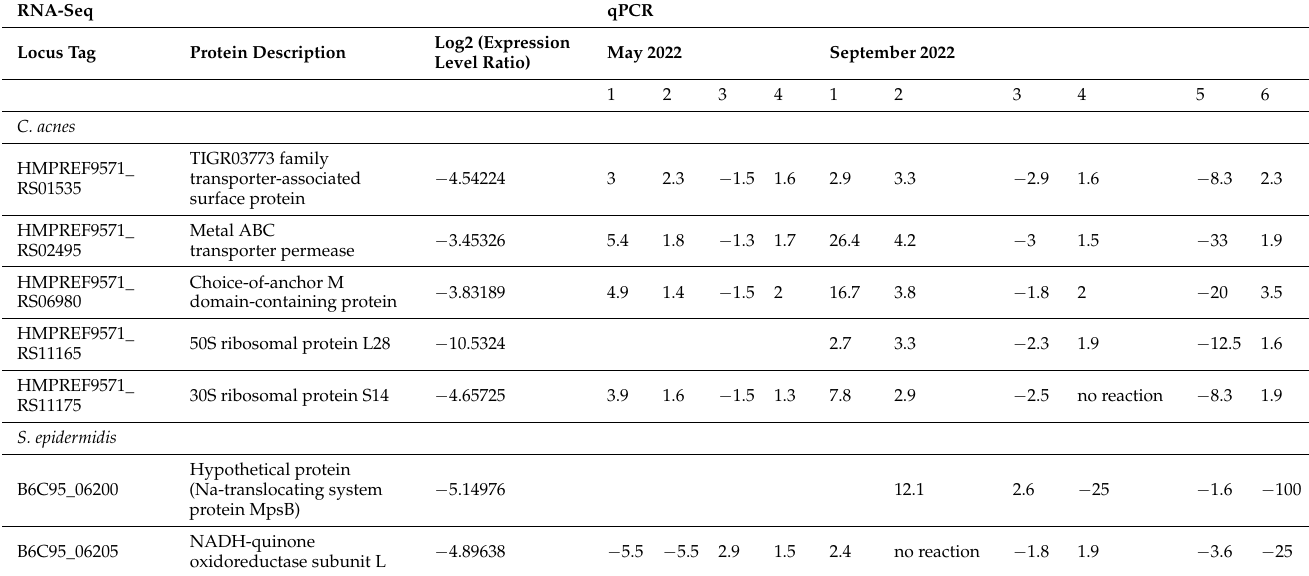
Table 7. Comparison of RNA-seq and qPCR results in dual-species biofilms under anaerobic